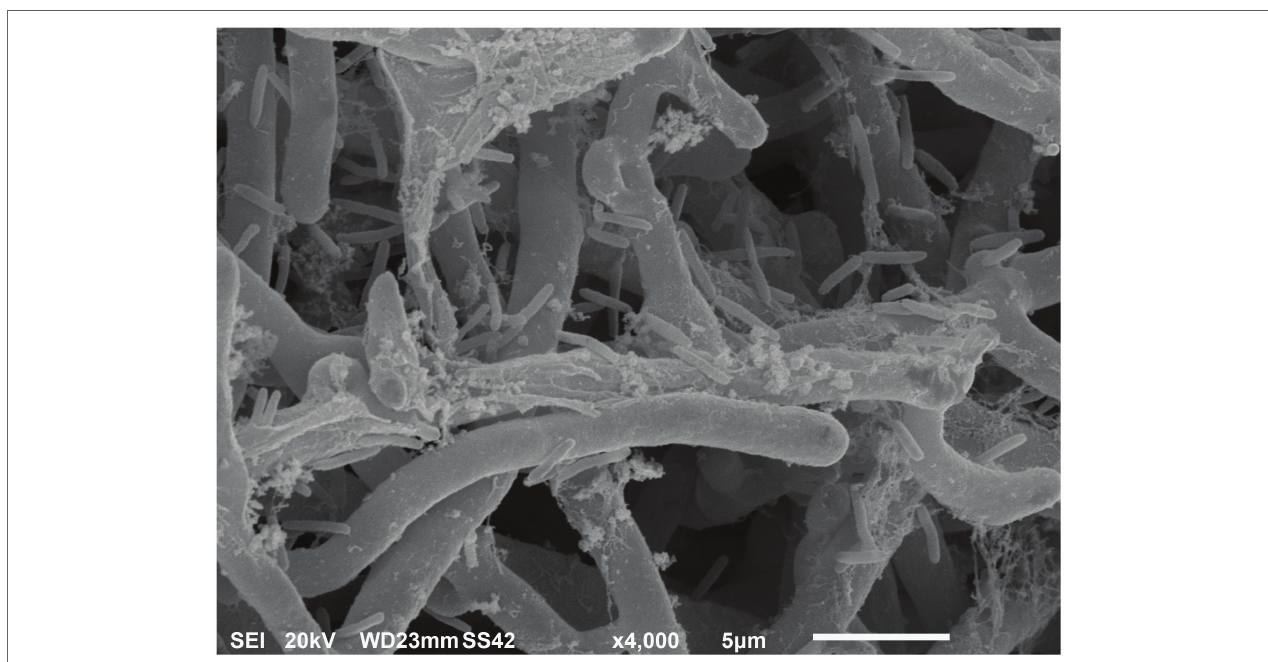
FIGURE 2 | Scanning electron micrograph showing P. alcaliphila cells attached to 4-day-old P. ostreatus biofilm after 6 h from bacterial inoculation at a 4,000× magnification.